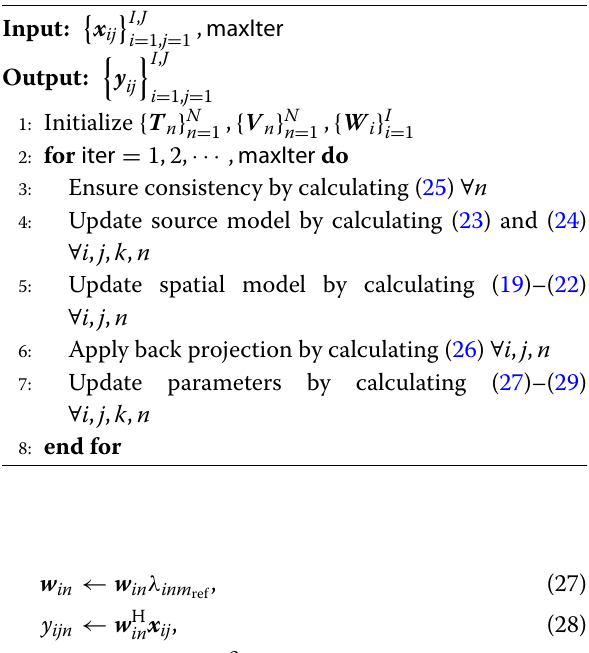
Algorithm 1 Consistent